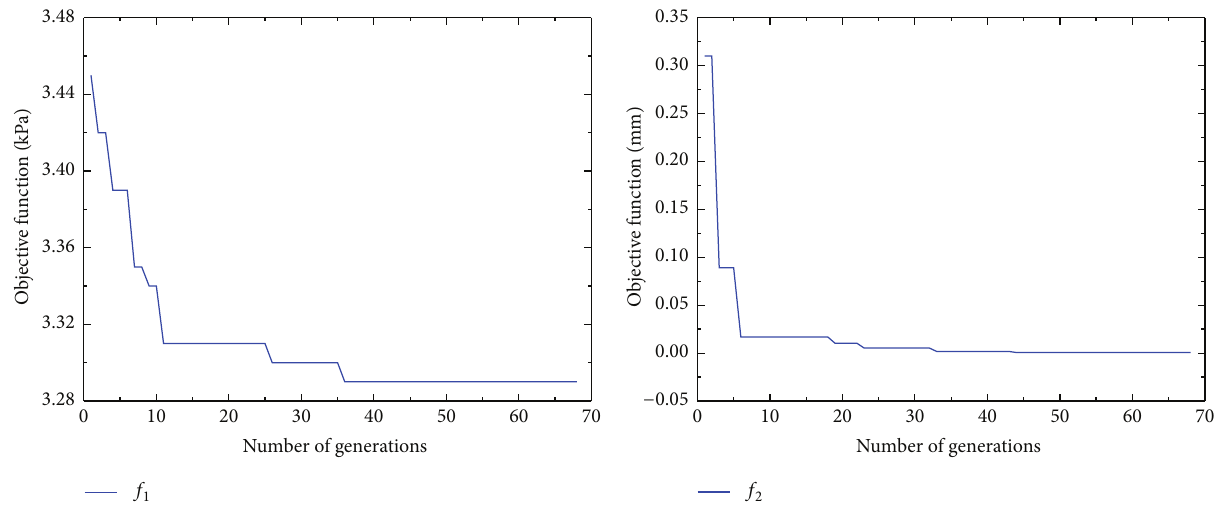
Figure 11: Evolution of the minimum objective function values as a function of the number of generations.